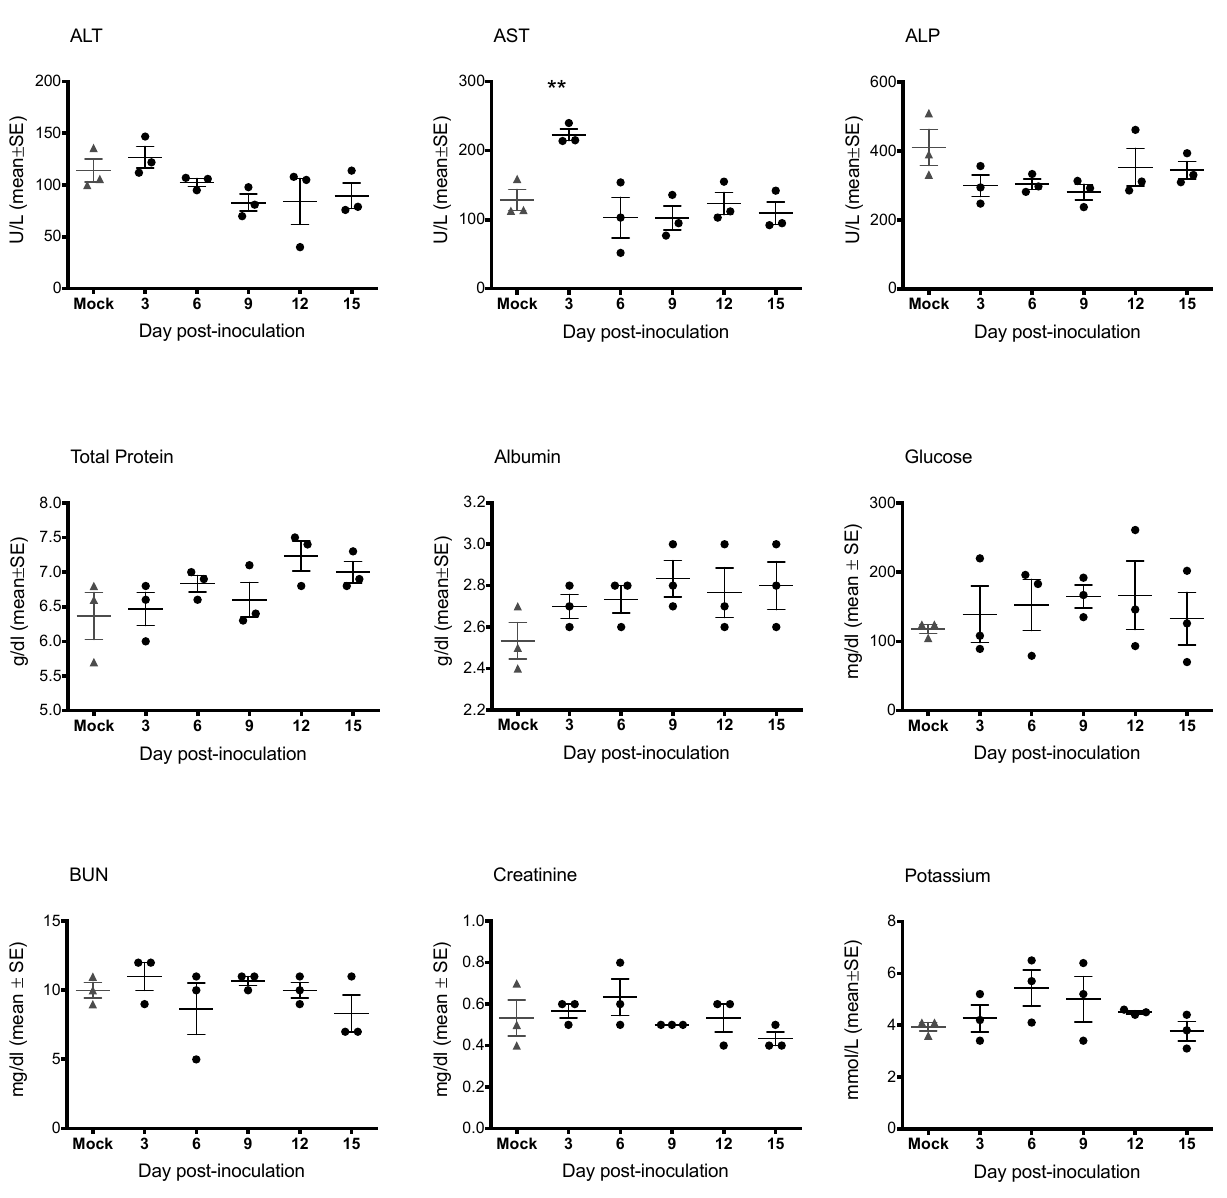
Figure 6. Blood chemistry measurements for Egyptian rousette bats inoculated with Sudan virus. Three Sudan virus-inoculated bats were euthanized on each of days 3, 6, 9, 12 and 15 post-inoculation. Mock-inoculated bats were euthanized on day 15. Mock = mock-inoculated controls, SUDV = Sudan virus, ALT = alanine aminotransferase, AST = aspartate aminotransferase, ALP = alkaline phosphatase, ALB = albumin, BUN = blood urea